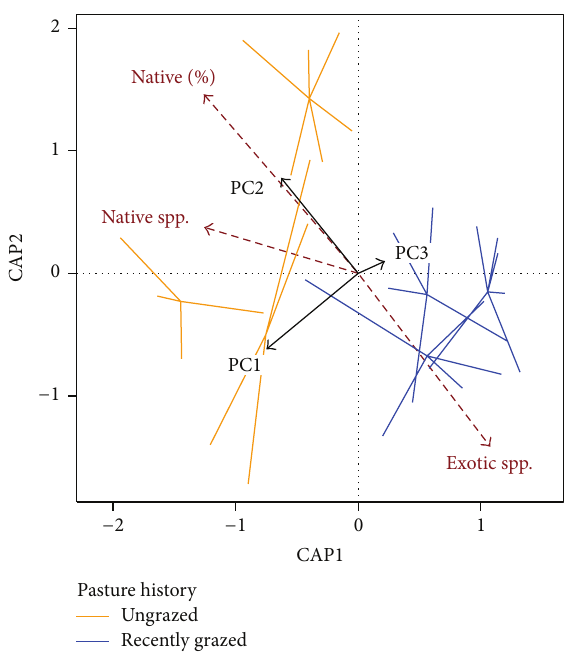
composition using composite variables of belowground properties created from soil and root PCA. Spiderplots group sampled mod- ified Whittaker plots by grazing history, thick black arrows show constrainingvariables,andthinredarrowsoverlayplantcommunity metadata fitted to the ordination (“Native (%)” = proportion of native species in community, “Native spp.” = native species richness, and “Exotic spp.” = exotic species